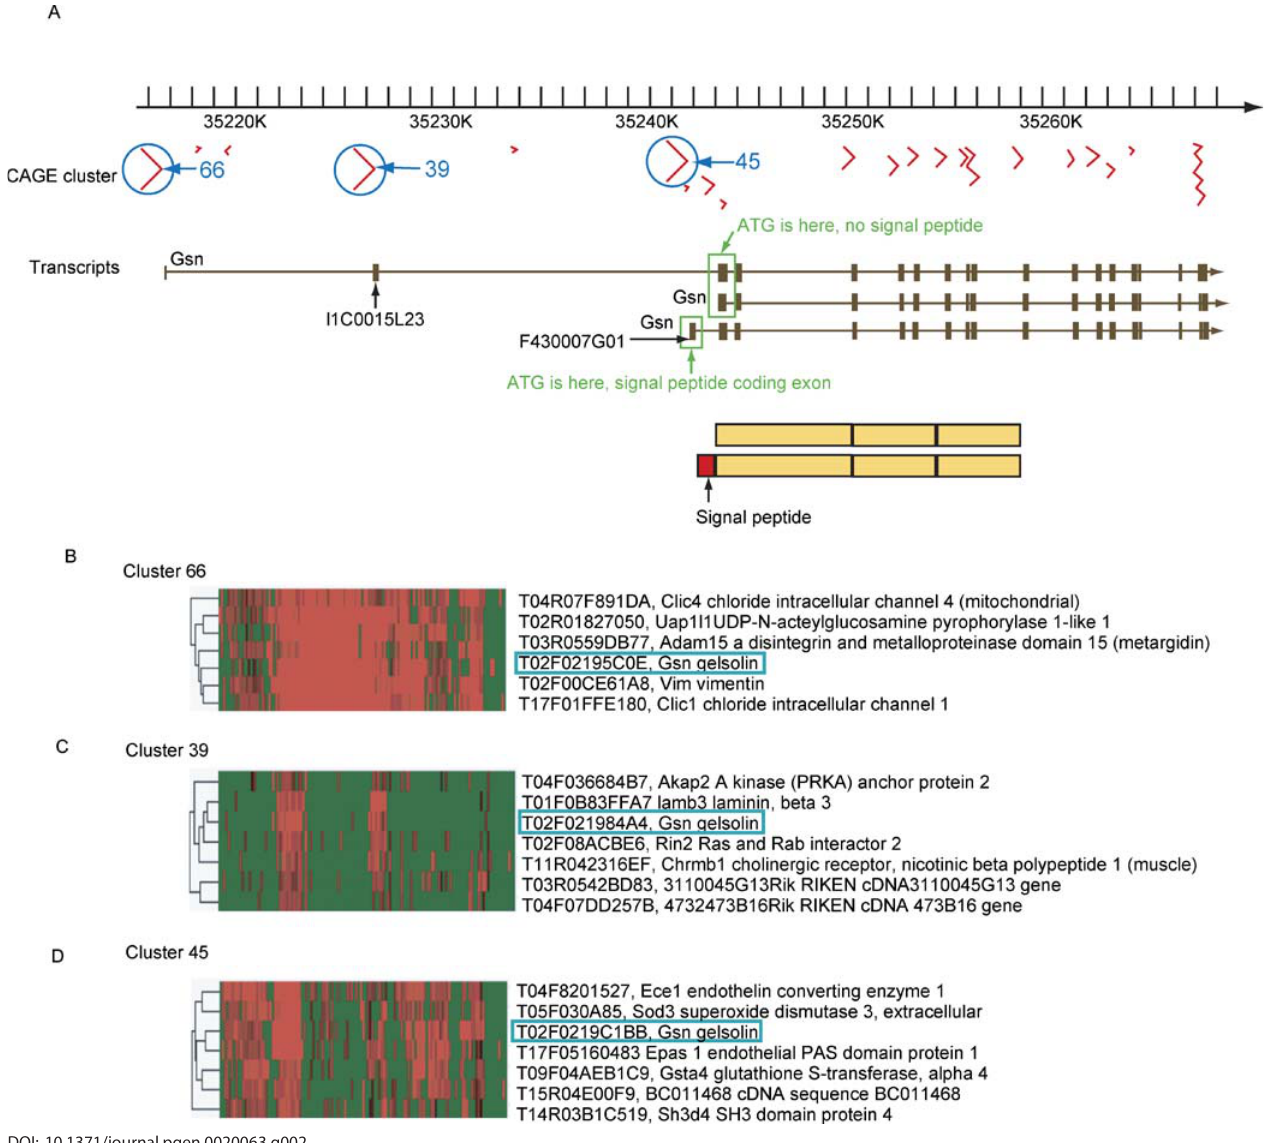
Figure 2. Gene Expression Is Driven by Context: The Mouse Gelsolin Multiple Promoters (A) Map of various isoforms of gelsolin mRNAs on the genome. There are three main TSSs, indicated by blue circles. The numbers are the arbitrary expression cluster numbers (clusters 66, 39, and 45) where these TSSs were assigned. The two upstream promoters produce RNAs that encode for the cytoplasmic isoform, while the third main promoter (cluster 45) encodes an mRNA that produces the secreted isoform of gelsolin. (B–D) The expression context of the three promoters is different. The x- axis shows different tissues based on their transcriptional similarity, and the y- axis shows TSS clustering. Various forms of gelsolin are expressed in different transcriptional contexts, emphasizing the importance of distinguishing between promoters and isoforms in the expression analysis.